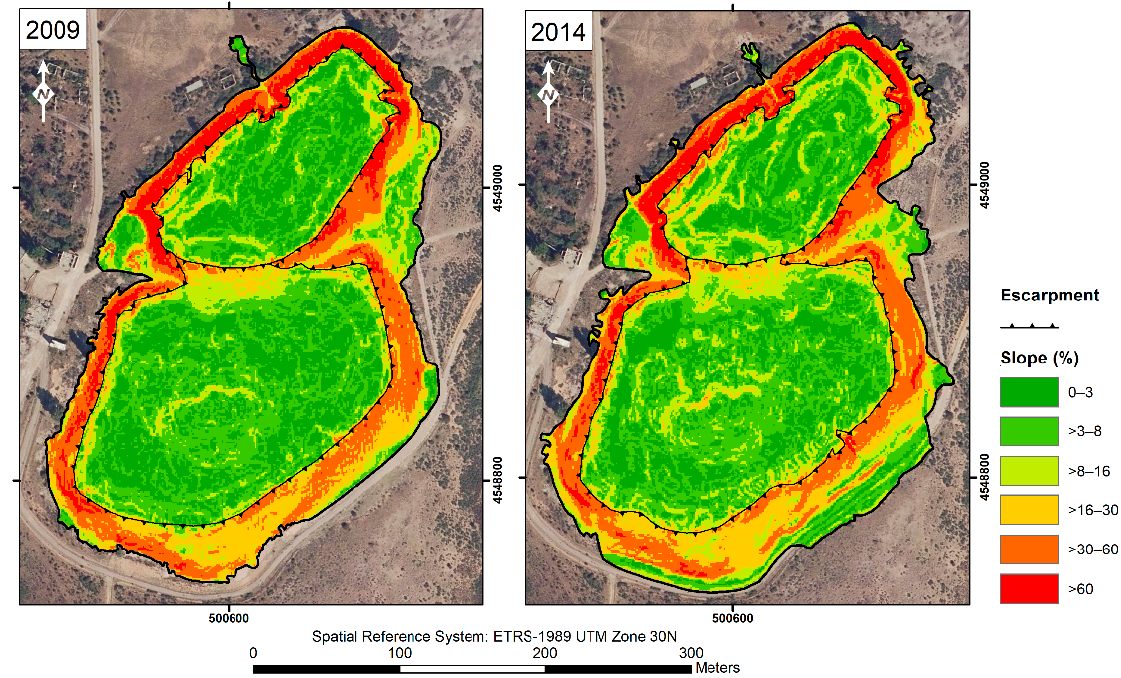
Figure 7. Slope map for both ponds corresponding to the light detection and ranging (LiDAR) flights of 2009 and 2014.